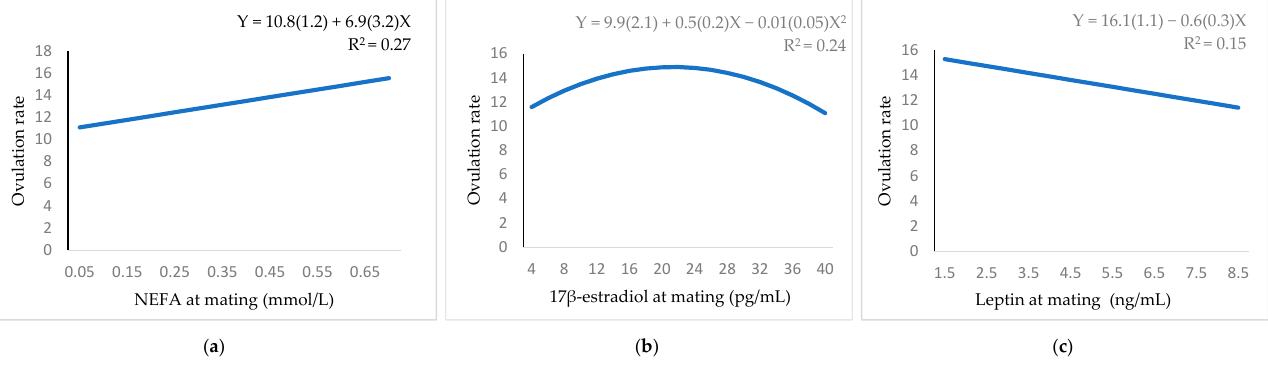
Perirenal fat thickness at 12 d of gestation(mm)